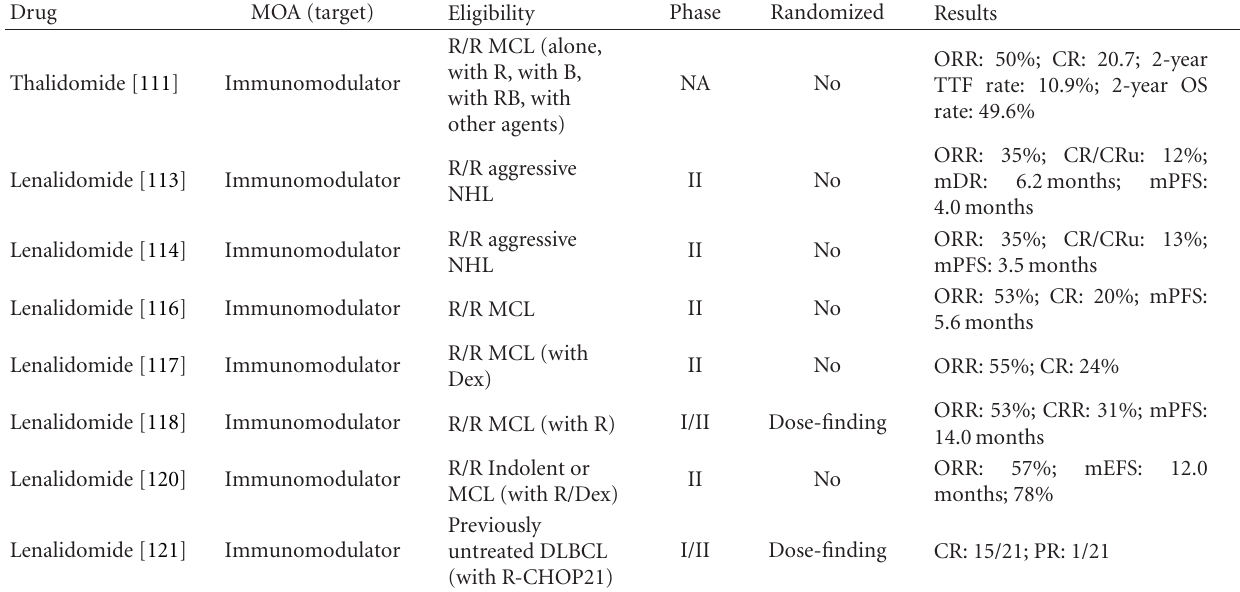
Table 4: Immunomodulatory agents in clinical development for the treatment of aggressive NHL. [B: bortezomib; CR: complete response; CRR: complete response rate; CRu: unconfirmed CR; Dex: dexamethasone; MCL: mantle cell lymphoma; mDR: median duration of response; mEFS: median event-free survival; MOA: mechanism of action; mPFS: median progression-free survival; NHL: non-Hodgkin lymphoma; ORR: overall response rate; OS: overall survival; PR: partial response; R: rituximab; R-CHOP21: cyclophosphamide,